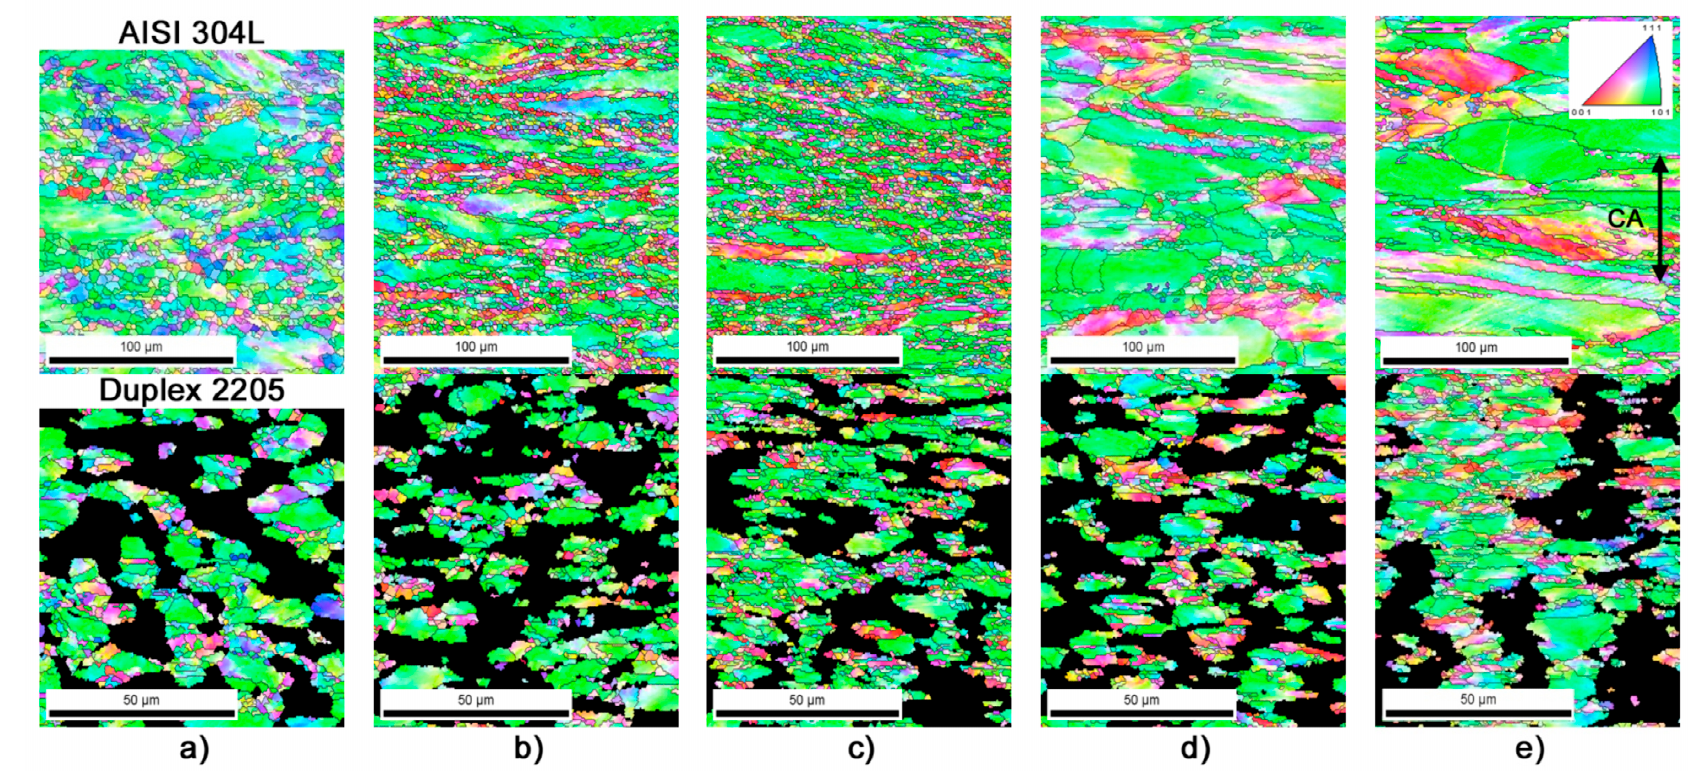
Figure 13. OIM micrographs on zone C for deformed γ -phase microstructure evolved in the AISI 304L and DDS 2205 steel processed by one-stage forging process at: ( a ) 20 °C; ( b ) 400 °C; ( c ) 500 °C; ( d ) 600 °C; and ( e ) 700 °C. The inverse pole figure is shown for the compression z-axis (CA). The black lines indicate high-angle boundaries (HABs) while the big black areas correspond to the missed ferrite grains.